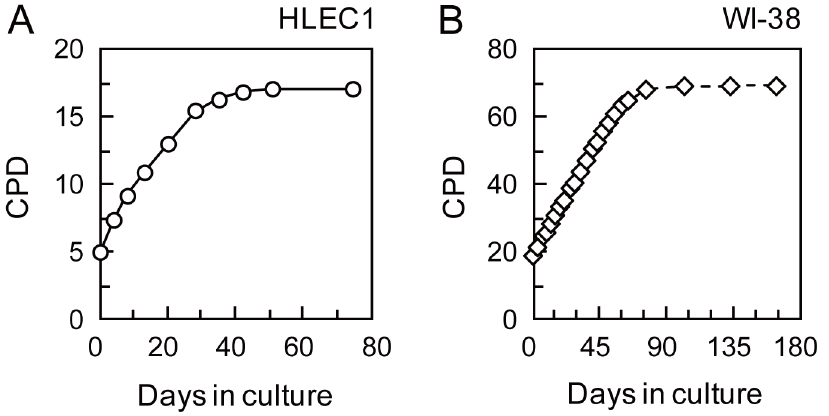
Figure 2. Growth curve of HLEC1 (A) and WI-38 (B). HLEC1 at CPD 5.0 and WI-38 at CPD 19.0 were plated and serially passaged with weekly replenishment. The population doubling times of HLEC1 and WI-38 were estimated to be 66.6 h at CPD 5.0–15.5 and 32.4 h at CPD 19.0–64.9, respectively. HLEC1 and WI-38 ceased to divide at CPD 17.1 and 69.1, respectively.